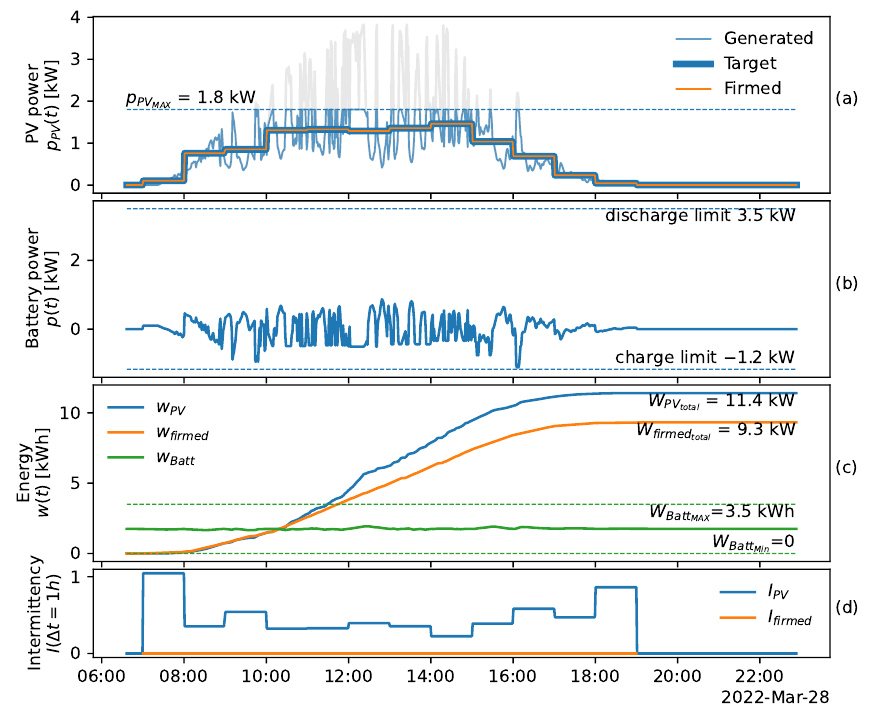
Figure 28. Simulated firming of renewables using real solar data without power limits: ( a ) PV generation with significant intermittency; ( b ) battery power and its limits; ( c ) battery energy and generated energy; ( d )